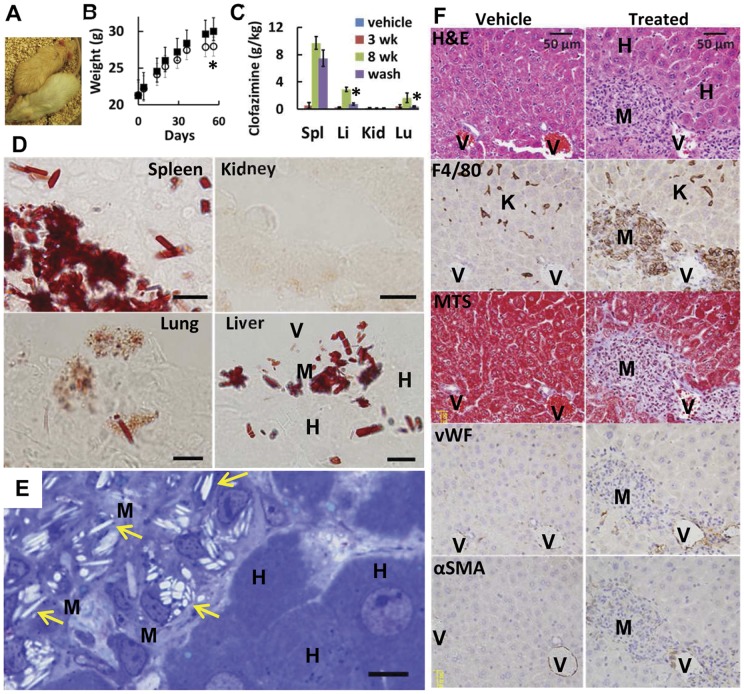
Clofazimine inclusions formed in macrophage-like cells in vivo.(A) Mice fed with clofazimine (above) showed reddish pigmentation visible in the ear, tail, and skin when compared to mice treated with vehicle only (below). (B) Weight gains in mice fed with and without clofazimine were comparable (N = 40, ▪, vehicle; ○, treated; *, P<0.01, end-point T-test). (C) Biochemical analysis of various organs revealed differences in the accumulation and retention of clofazimine after wash out (*, P<0.01, N = 5 per group, ANOVA). (D) Ruby red inclusions appeared in frozen sections of spleen, lung and liver, but not in kidneys of 8 wk supplemented diet. H, hepatocyte; V, blood vessel; M, microgranulomas. (E) Intracellular inclusions were extracted in perfusion-fixed liver upon ethanol-dehydration and staining with toluidine blue. Arrows indicate needle-like cavities remaining after extraction. (F) Histological sections revealed cellular changes in liver of mice fed with clofazimine. H&E staining, F4/80 macrophage specific marker, Masson's trichrome staining (MTS, collagen fibers), von Willebrand factor (vWF, endothelium) and alpha smooth muscle actin (αSMA). K, Kupffer cells. Scale bar  = 10 µm unless otherwise indicated.